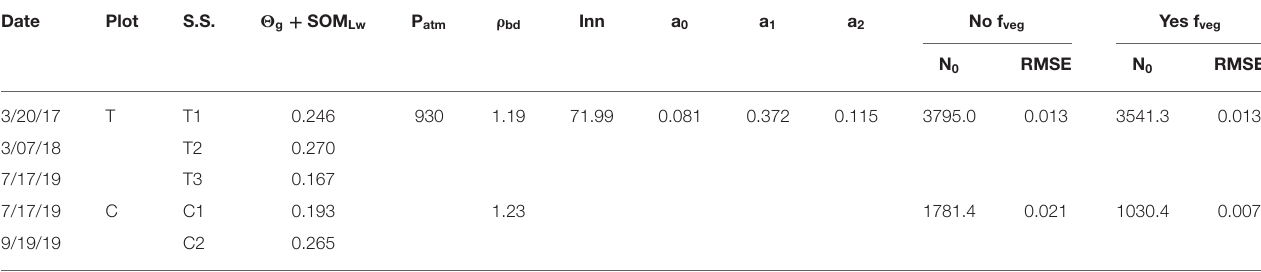
TABLE 6 | Soil characteristics and variables for CRNP